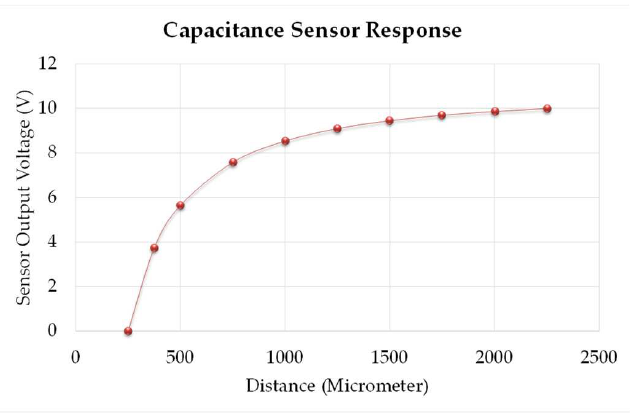
Figure 7. Response of capacitance sensor for different positions of flat surface.